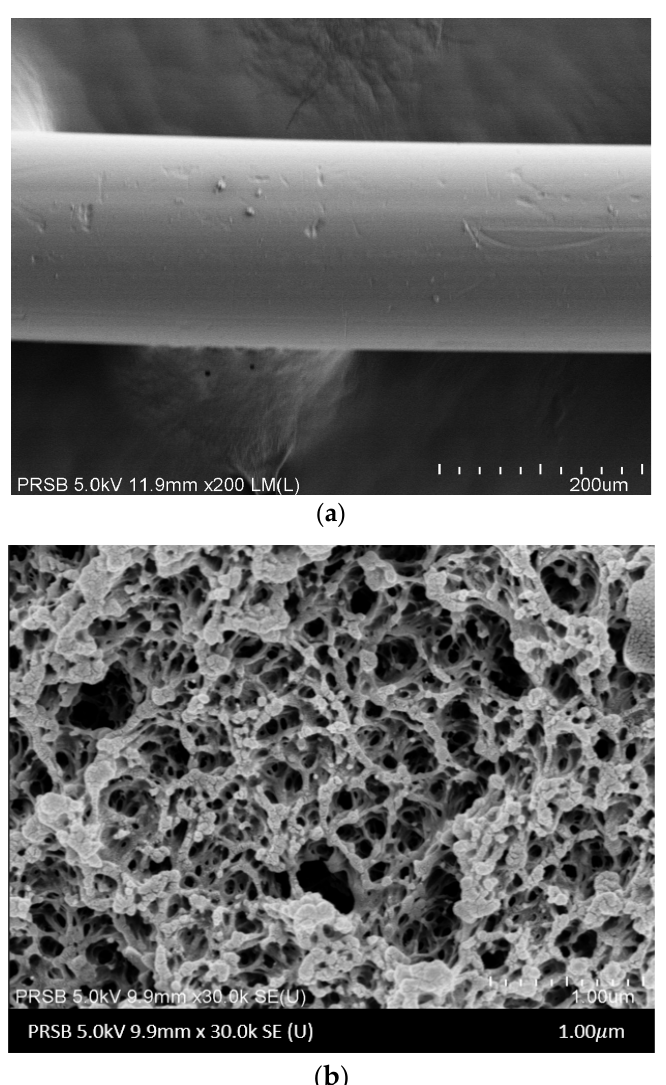
Figure 2. Surface ( a ) and cross-sectional ( b ) morphology FESEM image of the hollow fiber membrane fabricated in this study.